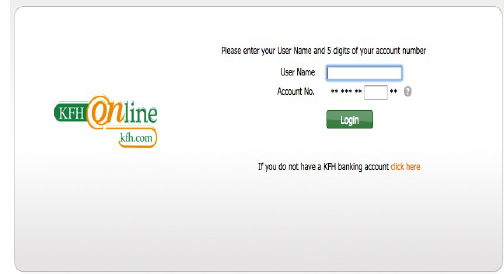
Figure 1-1: Username and Account Number.